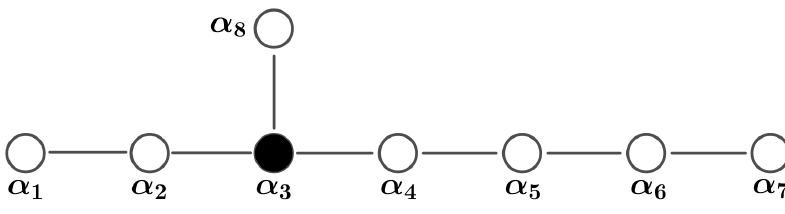
Figure 7 . E 8 Dynkin